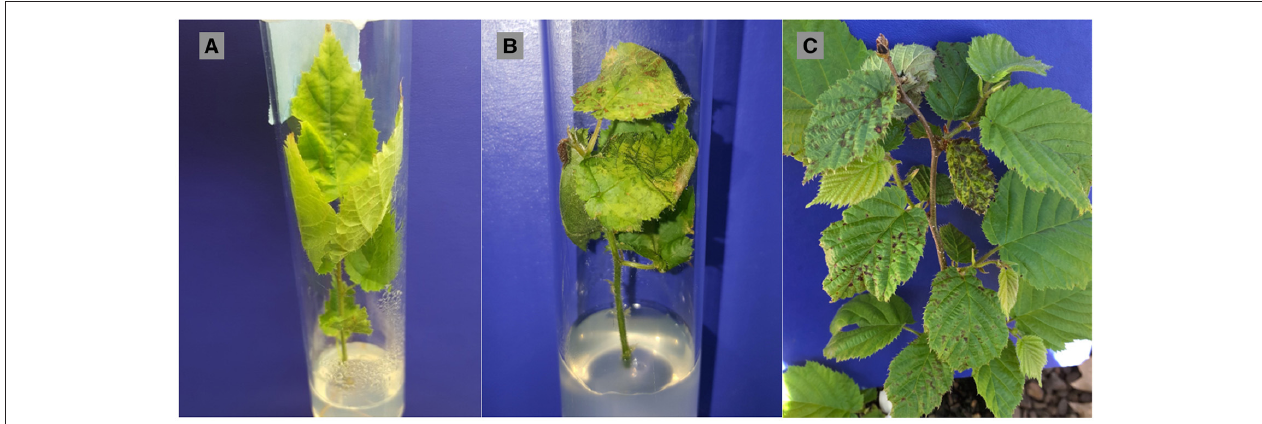
FIGURE 1 | Symptoms following controlled inoculations of both in vitro and in vivo plant material. (A) “Barcelona” explant from the in vitro experiment treated with sterilized deionized water (control) showing chlorosis from growing on the water-agar medium, (B) “Jefferson” explant from in vitro experiment showing severe chlorosis and water-soaked lesions at 5 weeks post-inoculation with Xanthomonas arboricola pv. corylina strain JL2600, and (C) “Jefferson” potted tree ( in vivo ) showing severe chlorosis and water-soaked lesions at 6 months post-inoculation with JL2600.